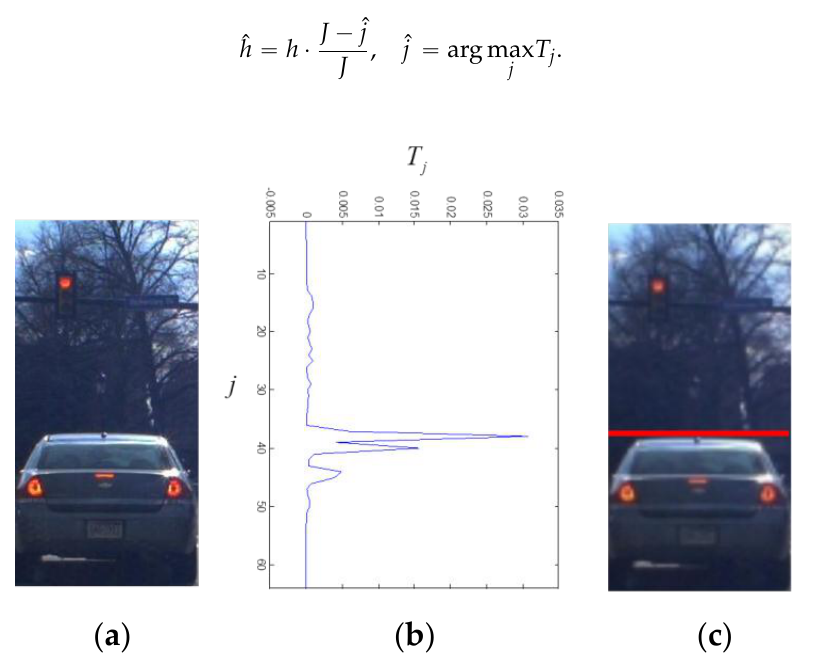
Figure 10. The results of estimating vehicle height: ( a ) is the hypothesized window; ( b ) is the total score for vehicle height estimation; and ( c ) shows the estimated vehicle height represented by the red line.